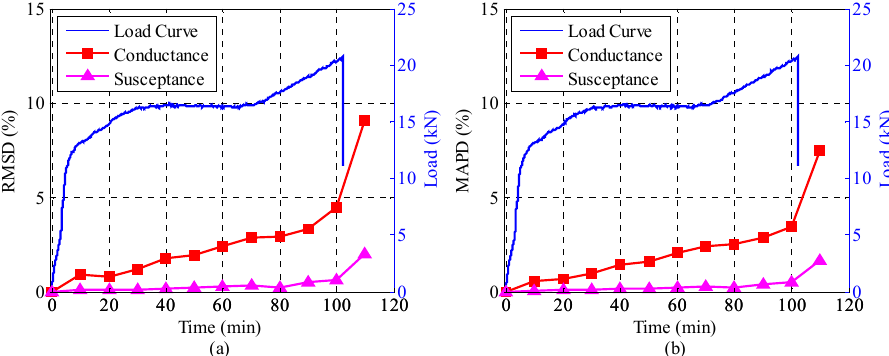
Figure 10. The damage matrices of the conductance and susceptance for SA-3 during the test. ( a ) RMSD, ( b ) MAPD.